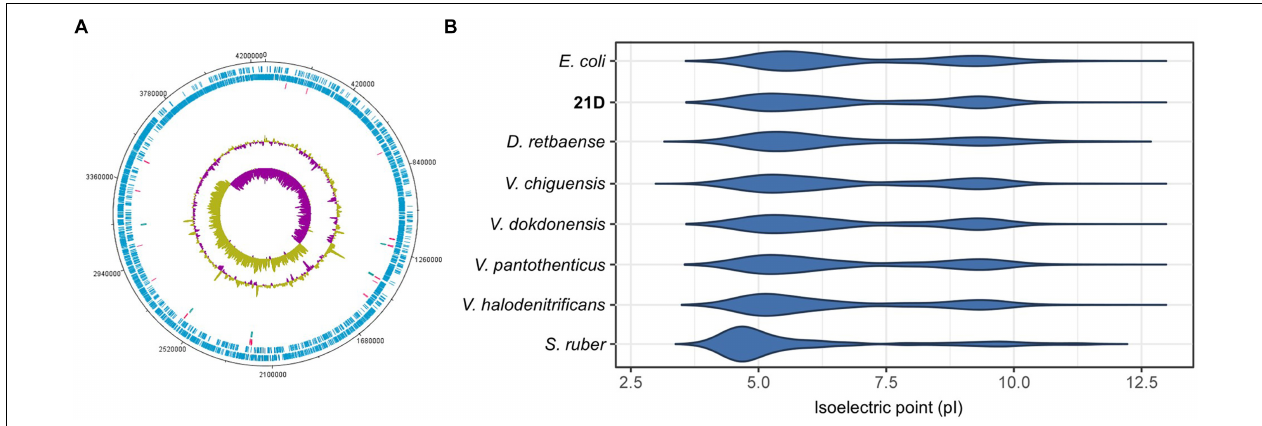
FIGURE 2 | Circular map of the genome (A) and isoelectric point of the proteome (B) of V. dokdonensis strain 21D. In (A) , marked characteristics are shown from outside to the center: CDS on forward strand, CDS on reverse strand, tRNA, rRNA, GC content and GC skew. In (B) , are reported the isoelectric point of the proteome of E. coli DSM 30083, V. pantothenticus DSM 26 T , V. chiguensis NTU-101 T , V. dokdonensis Marseille-P2545, V. halodenitrificans JCM 12304, S. ruber DSM 13855, D. retbaense DSM 5692.